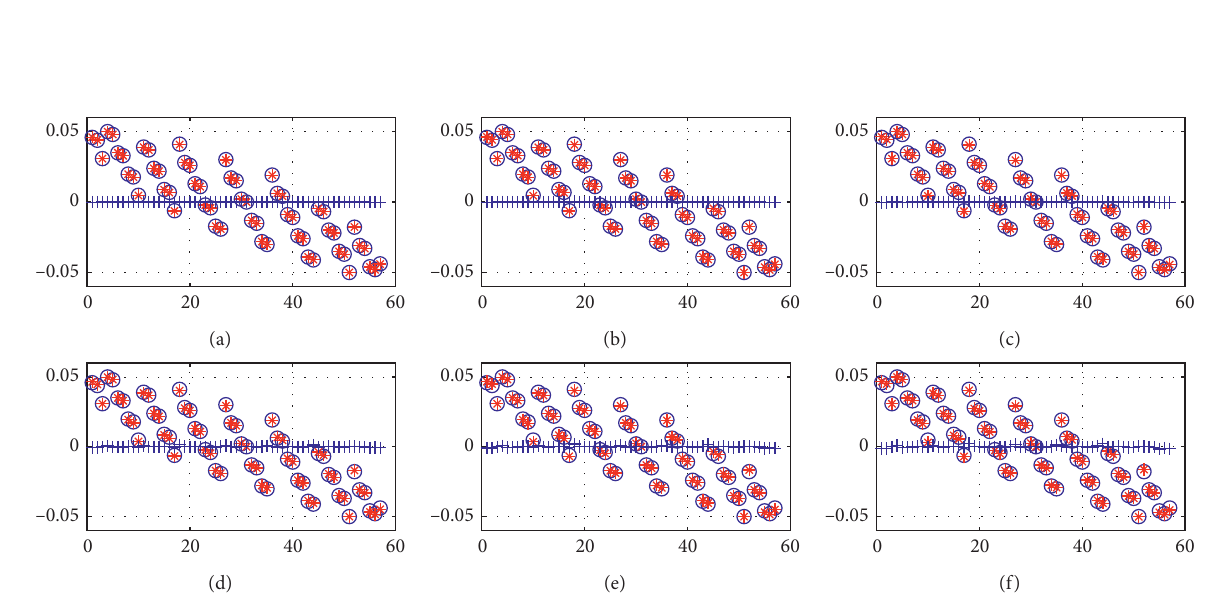
Figure 22: The comparison between the values of the first term (blue oooo) and the imaginary part of the second term (red ∗∗∗∗ ) of (D.2) with SNR � ∞ , when the frequency is at 10 GHz, the incident direction is from (143.75 ° 84.66 ° ) to Array-3, the waveform is WF-1, and the number of snapshots is 512. Blue plus signs are the real part of the second term in (D.2). (a) Freq � 6GHz; (b) Freq � 8GHz; (c) Freq � 10GHz; (d) Freq � 14GHz; (e) Freq � 16GHz; (f) Freq � 18